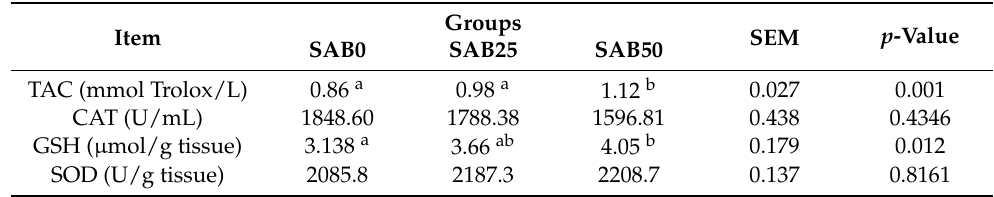
Table 3. Effect of dietary salicin standardized extract from SAB on liver oxidative stress biomarkers of broiler